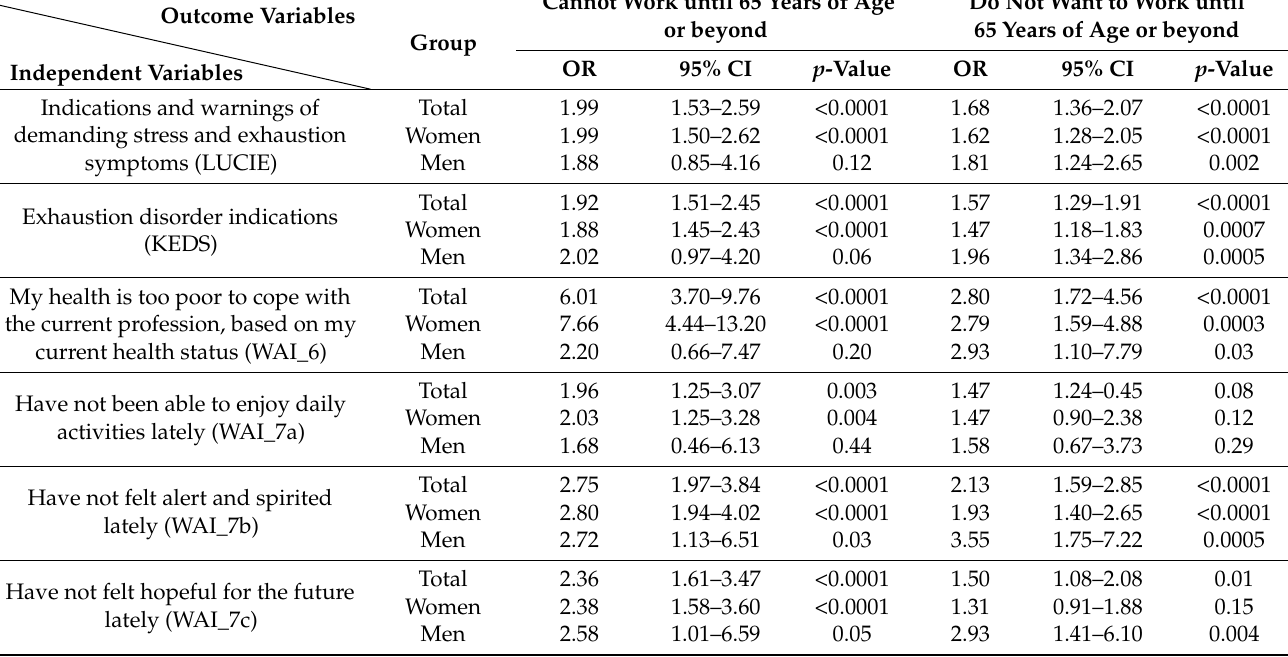
Table 2. Univariate estimates from multiple binary logistic regression with repeated measurements on school principals’ assessment of whether they “cannot work” or “do not want to work” until 65 years of age and beyond in association with the school principals’ experience of health problems in their situation for the total study population and stratified by sex. The results are presented as odds ratios (OR) with accompanying 95% confidence intervals (CI) and p